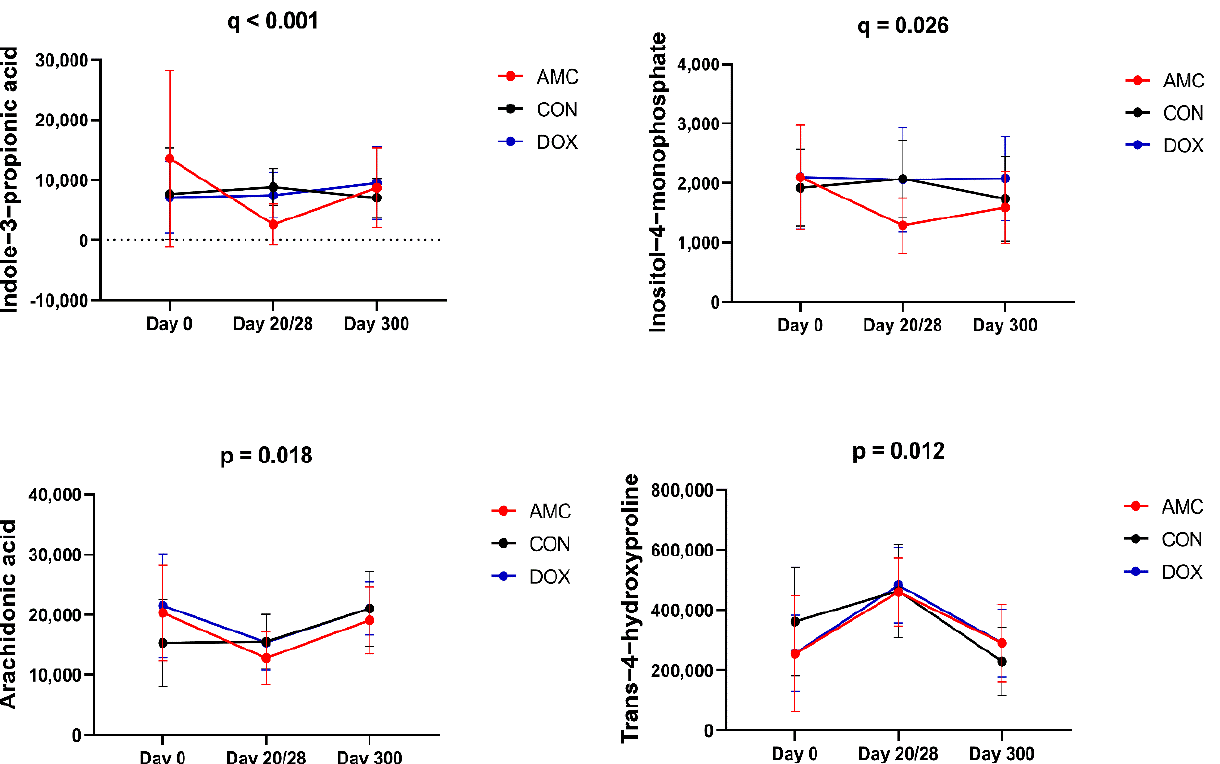
Figure 3. Abundance of serum metabolites that significantly differed between the AMC and CON groups on day 20/28 (indole-3-propionic acid, inositol-4-monophosphate) and from day 0 to day 20 within AMC cats (arachidonic acid, trans-4-hydroxyproline). Means and standard deviations are displayed.